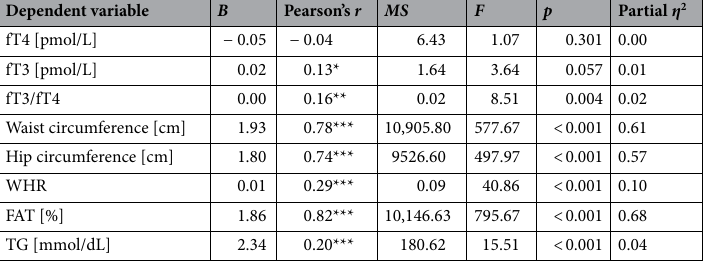
Parametrs Mean ± SD; median (range),